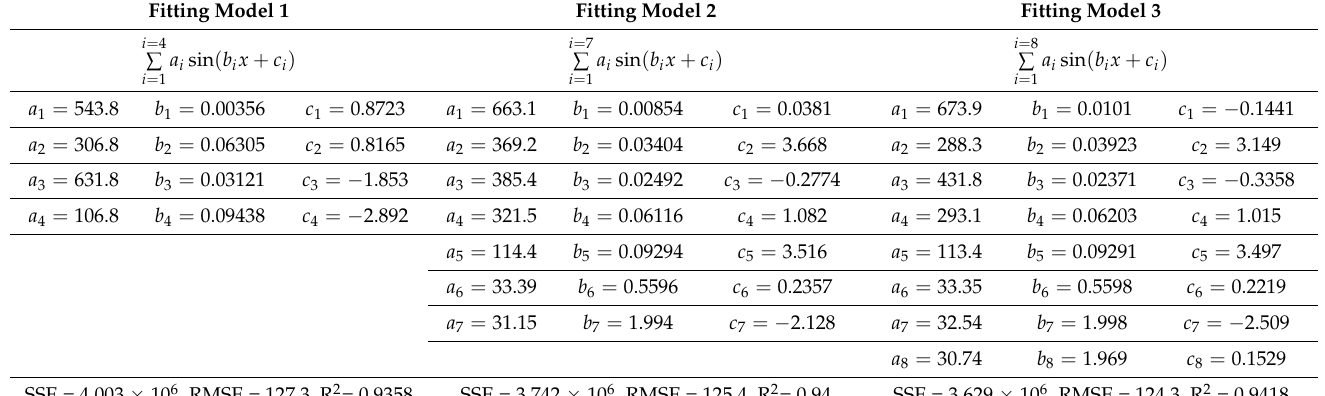
Table 1. Used mathematical fitting models for Egypt data with optimized coefficients.